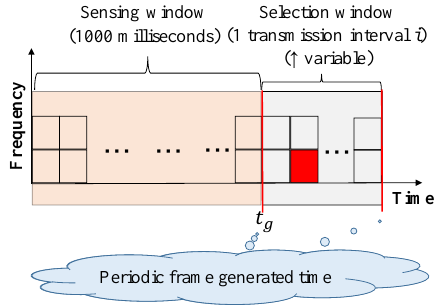
Figure 2. The illustration of the sensing window and selection window.